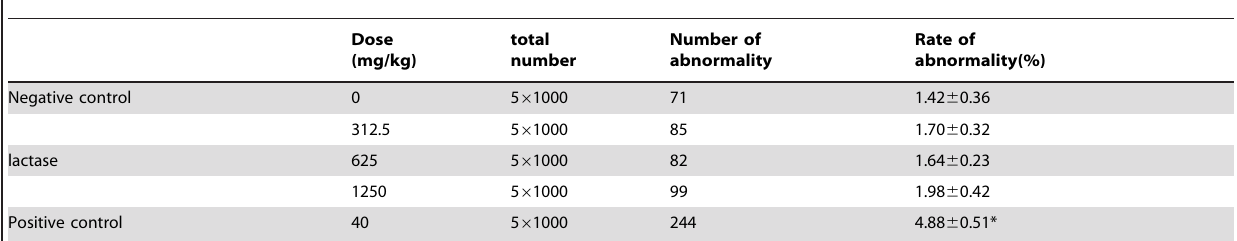
Table 4. Mice sperm abnormality rate treat with lactase (n